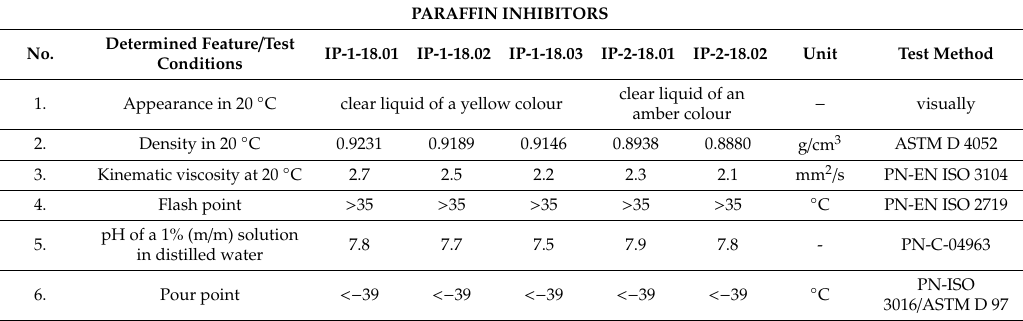
Table 2. Properties of para ffi n inhibitors IP-1-18.01, IP-1-18.02, IP-1-18.03, IP-2-18.01, and IP-2-18.02 used in the tests.